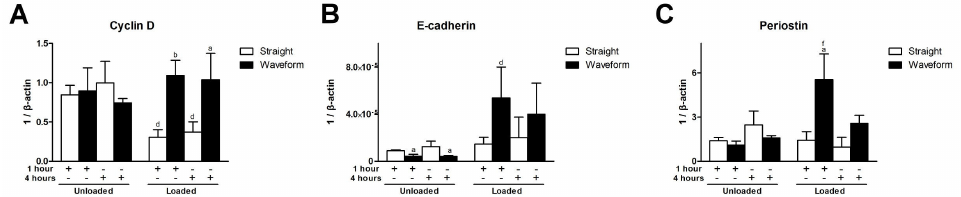
Figure 6. Gene expression profiles of PDL cells on the microfibers. ( A ) Cyclin D ( CCND1 ). ( B ) E-cadherin ( CDH1 ). ( C ) Periostin ( POSTN ). (Significant difference to the straight microfibers un- der the same loading condition at the same time point: a = p < 0.05, b = p < 0.01; significant difference to the straight microfibers without loading at the same time point: d = p < 0.05, f = p <